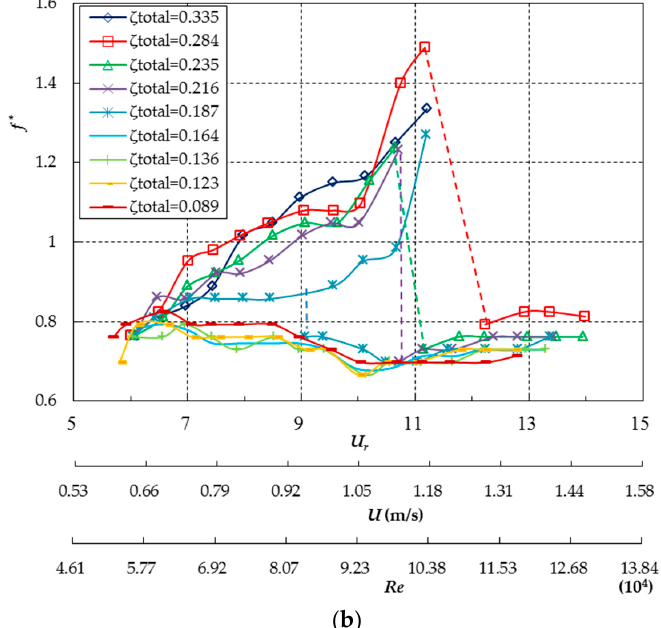
Figure 8. Amplitude and frequency ( a ) Amplitude ratio A * versus U r , U and Re for different ζ total ; ( b ) Frequency ratio f * versus U r , U and Re for different ζ total ; (Dashed lines denote hard excitation).